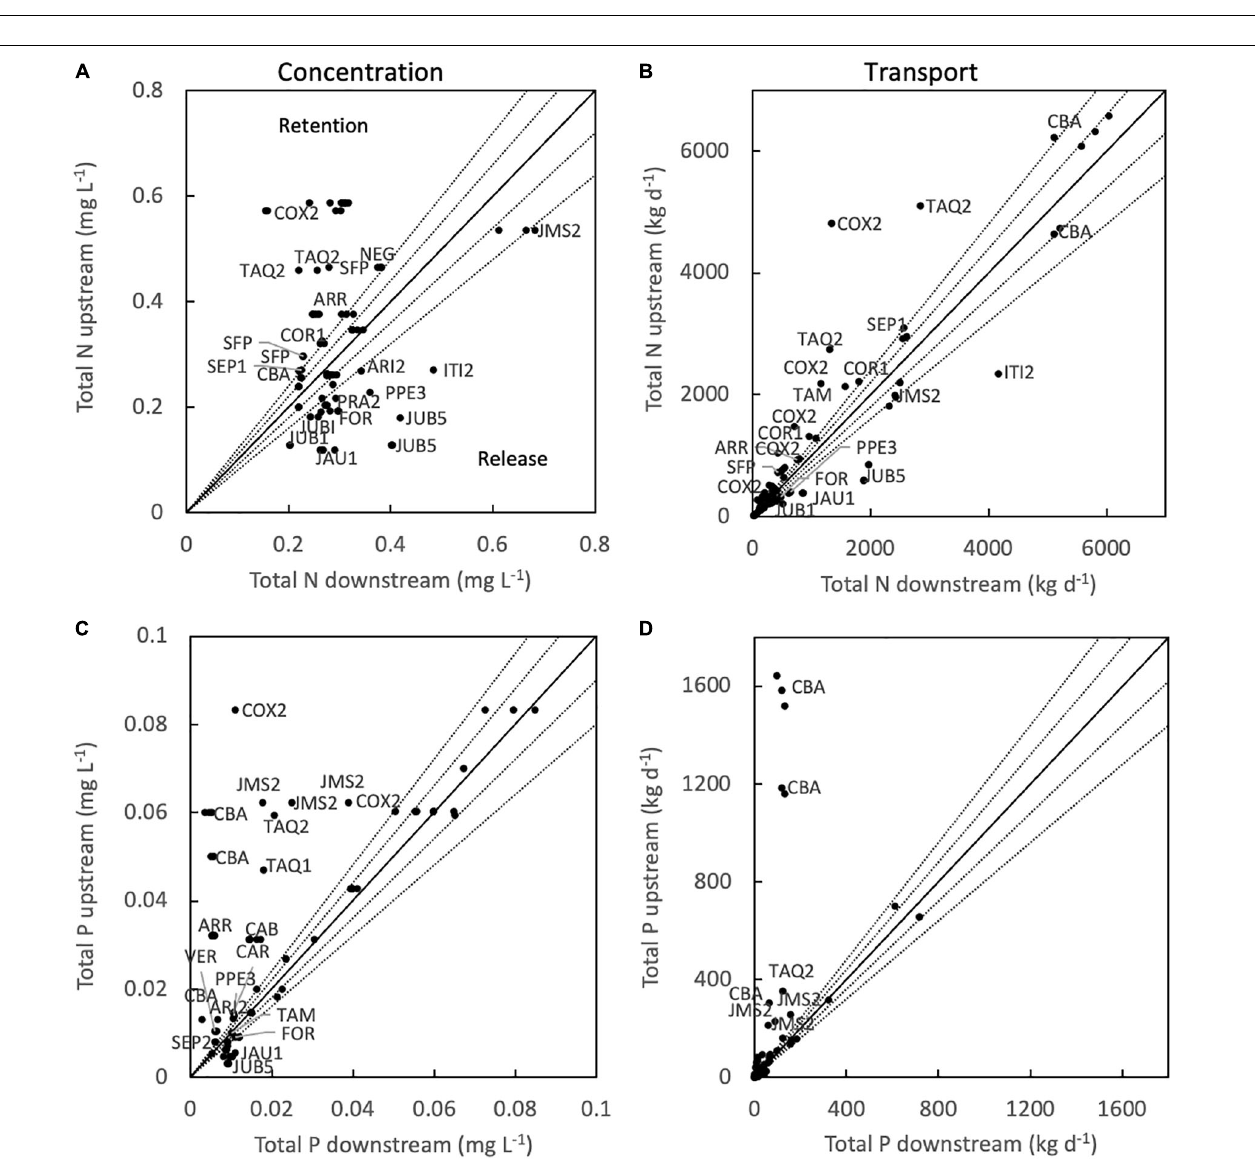
FIGURE 7 | Comparisons of neural network model predictions of changes in total nitrogen and phosphorus between upstream and downstream of future hydroelectric facilities, with river systems labeled by codes in Table 1 . (A) Total N concentrations, (B) total N transport, (C) total P concentrations, and (D) total P transport. Solid line shows the line of parity and dashed lines show bounds of ± 10 and ± 20% around that line; points above the line indicate net retention and those below indicate net release between the upstream and downstream sampling points. Upstream:downstream ratios that deviate considerably from 1:1 are identified with the codes shown in Table 1 . Both primary and secondary data are included in the figure and all data are in the Supplementary Table S5